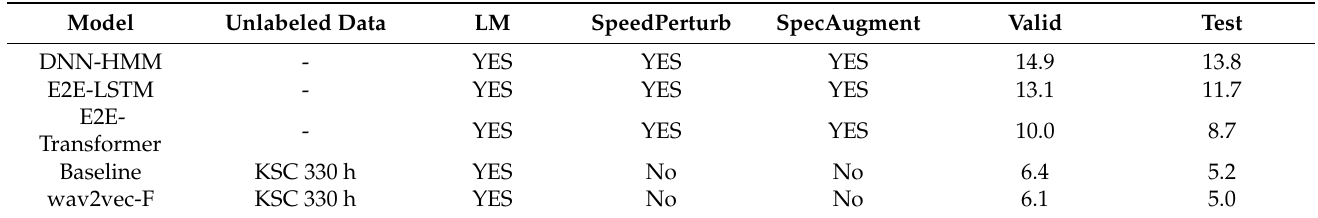
Table 5. The performance (WER) of different methods on the KSC valid set and test set when pre-training on the train set and fine-tuning on the valid set.